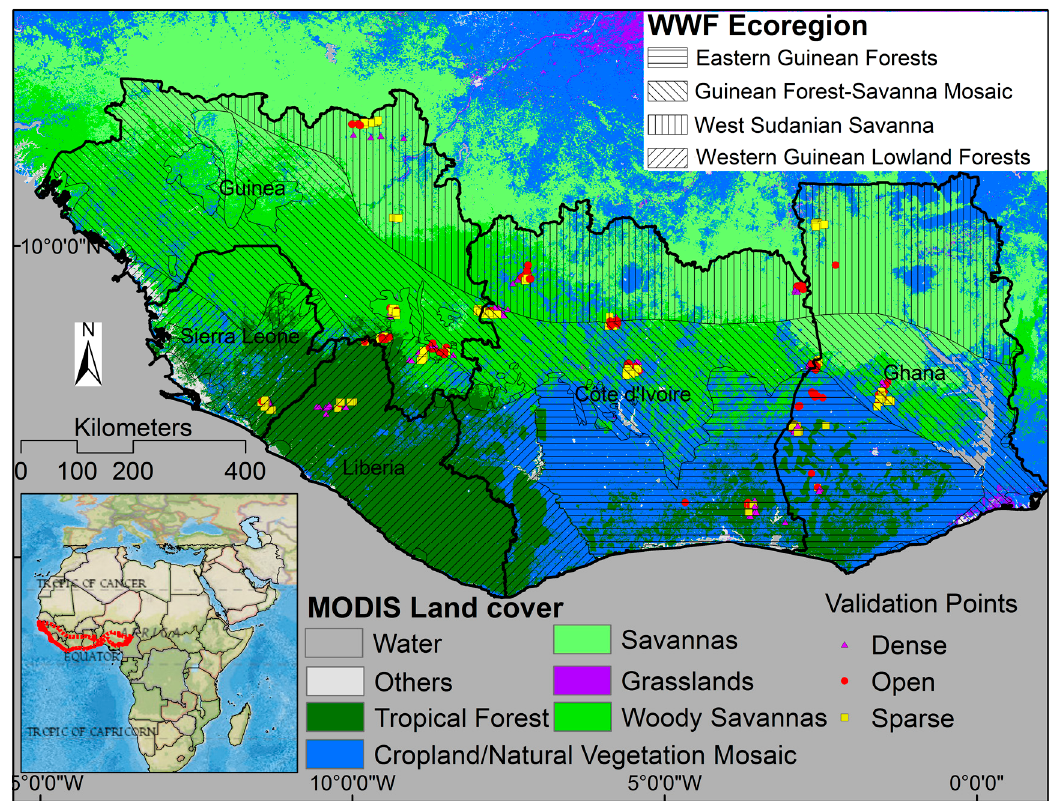
Figure 1. Study area, overlaid with World Wide Fund (WWF) terrestrial ecoregions and ground validation points. The land cover was based on the 0.5-km MODIS-based Global Land Cover